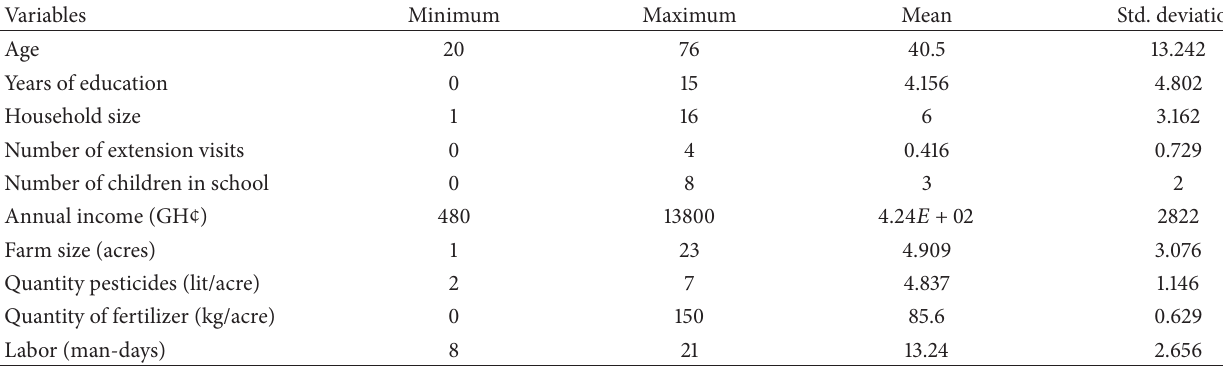
Table 3: Summary statistics of continuous